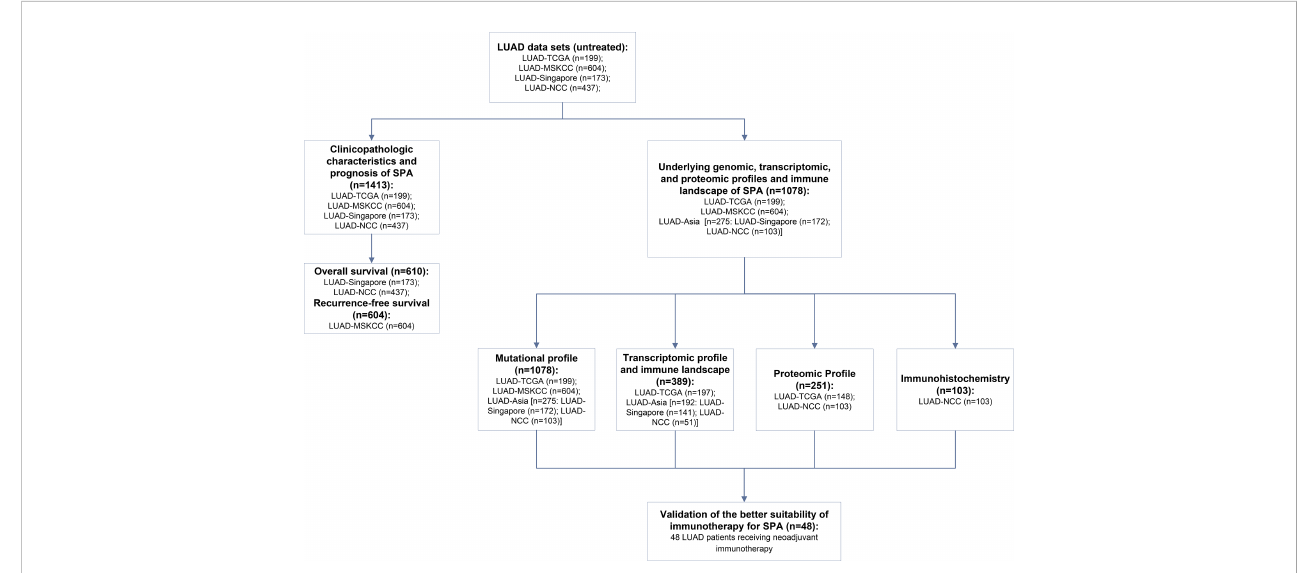
FIGURE 1 Flow diagram illustrating the study